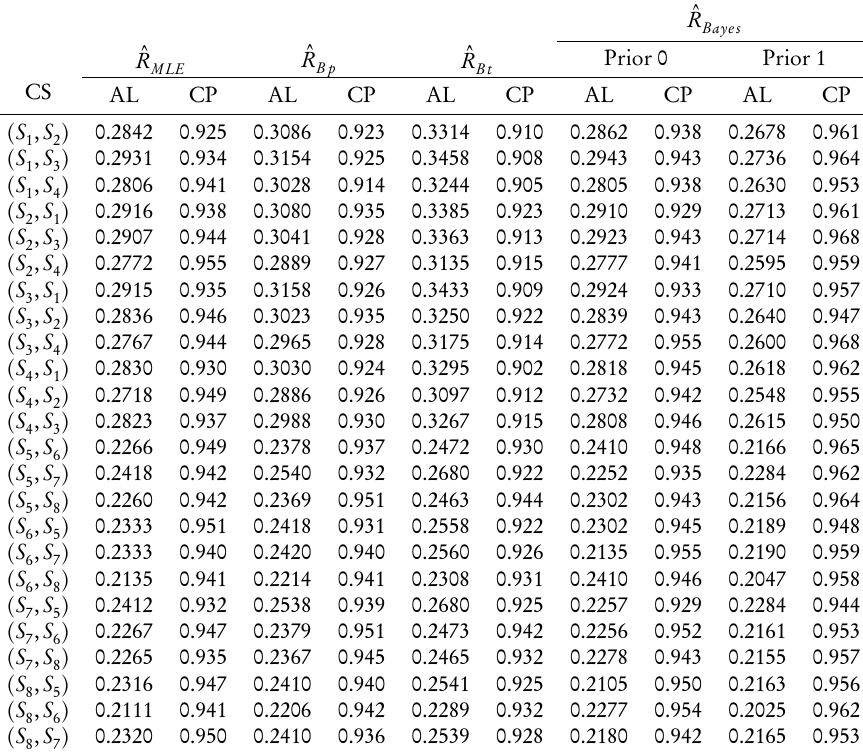
The AL and CP of 95% asymptotic, bootstrap confidence / HPD credible intervals of R when α = 1.5, β = 4.5, λ = 1 and R =